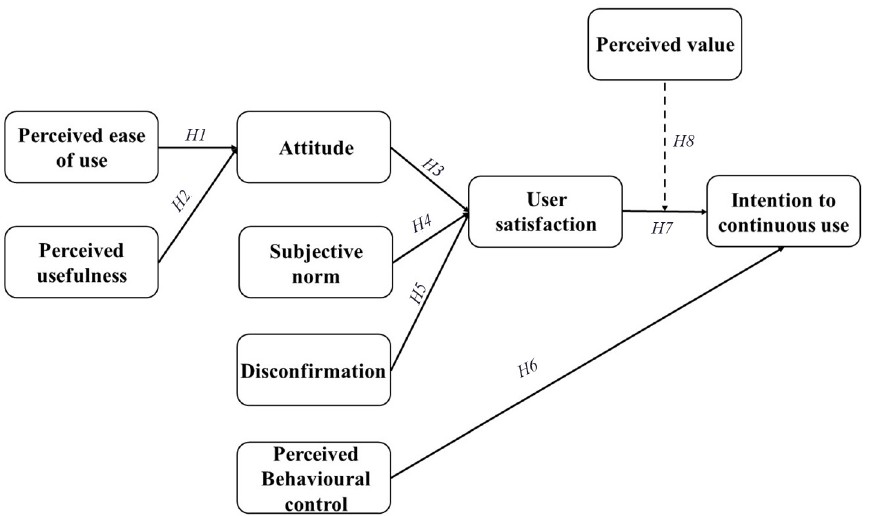
Figure 1. Research